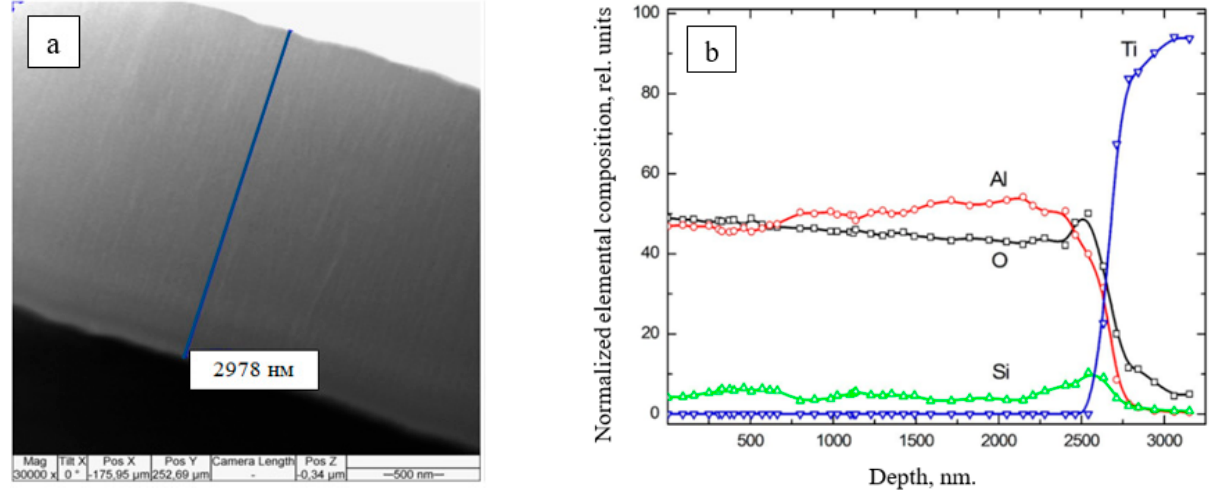
Figure 26. ( a ) A cross-section photograph of a ceramic coating on titanium. Experimental parameters: I e = 150 mA; U a = 1–15 kV; p = 8 Pa. ( b ) The elemental composition of the ceramic-based coating vs. the sample depth. Experimental parameters: p = 7.5 kW/cm 2 ; p = 8 Pa [135].